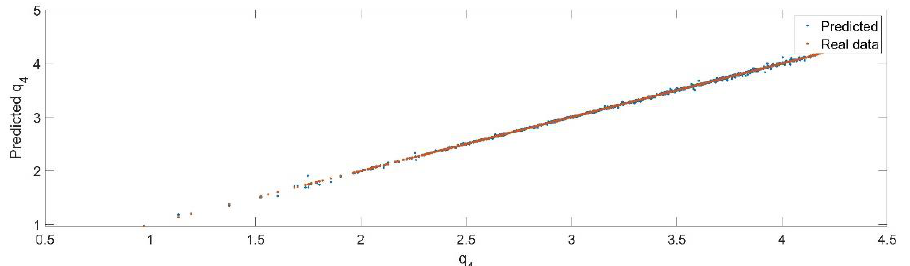
Figure 20. The comparison between the real data (the real value of q 4 ) and the predicted data (the